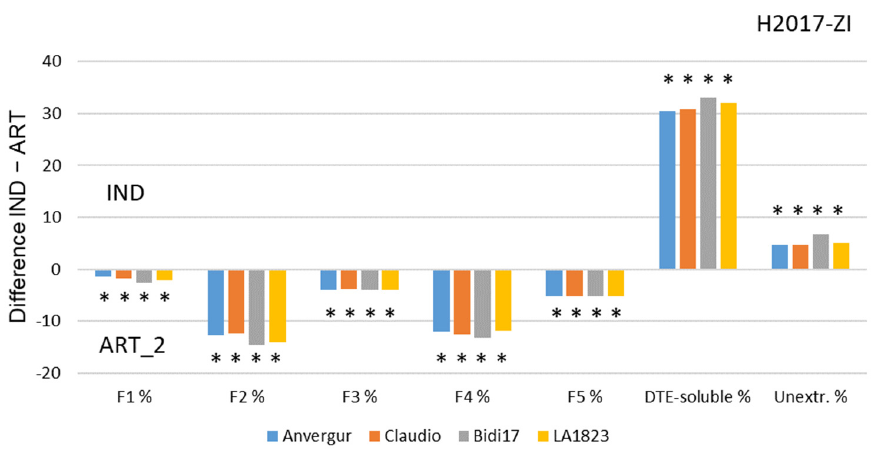
Figure 6. Differences between protein fractions (F1 to F5, DTE-soluble and unextractable) between dry pasta made according “Artisanal 2” and “Industrial” processes with stone-milled grains grown under ZI cropping system. When the bar is directed upwards, the effect is greater with the IND process; when it is directed downwards, the effect is greater with the ART_2 process. * Difference significant at 5%.